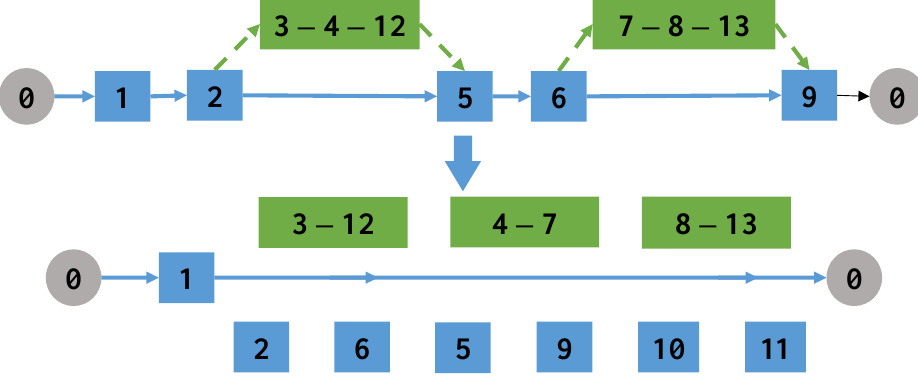
Figure 8. Destroy and reconnect the drone tasks.